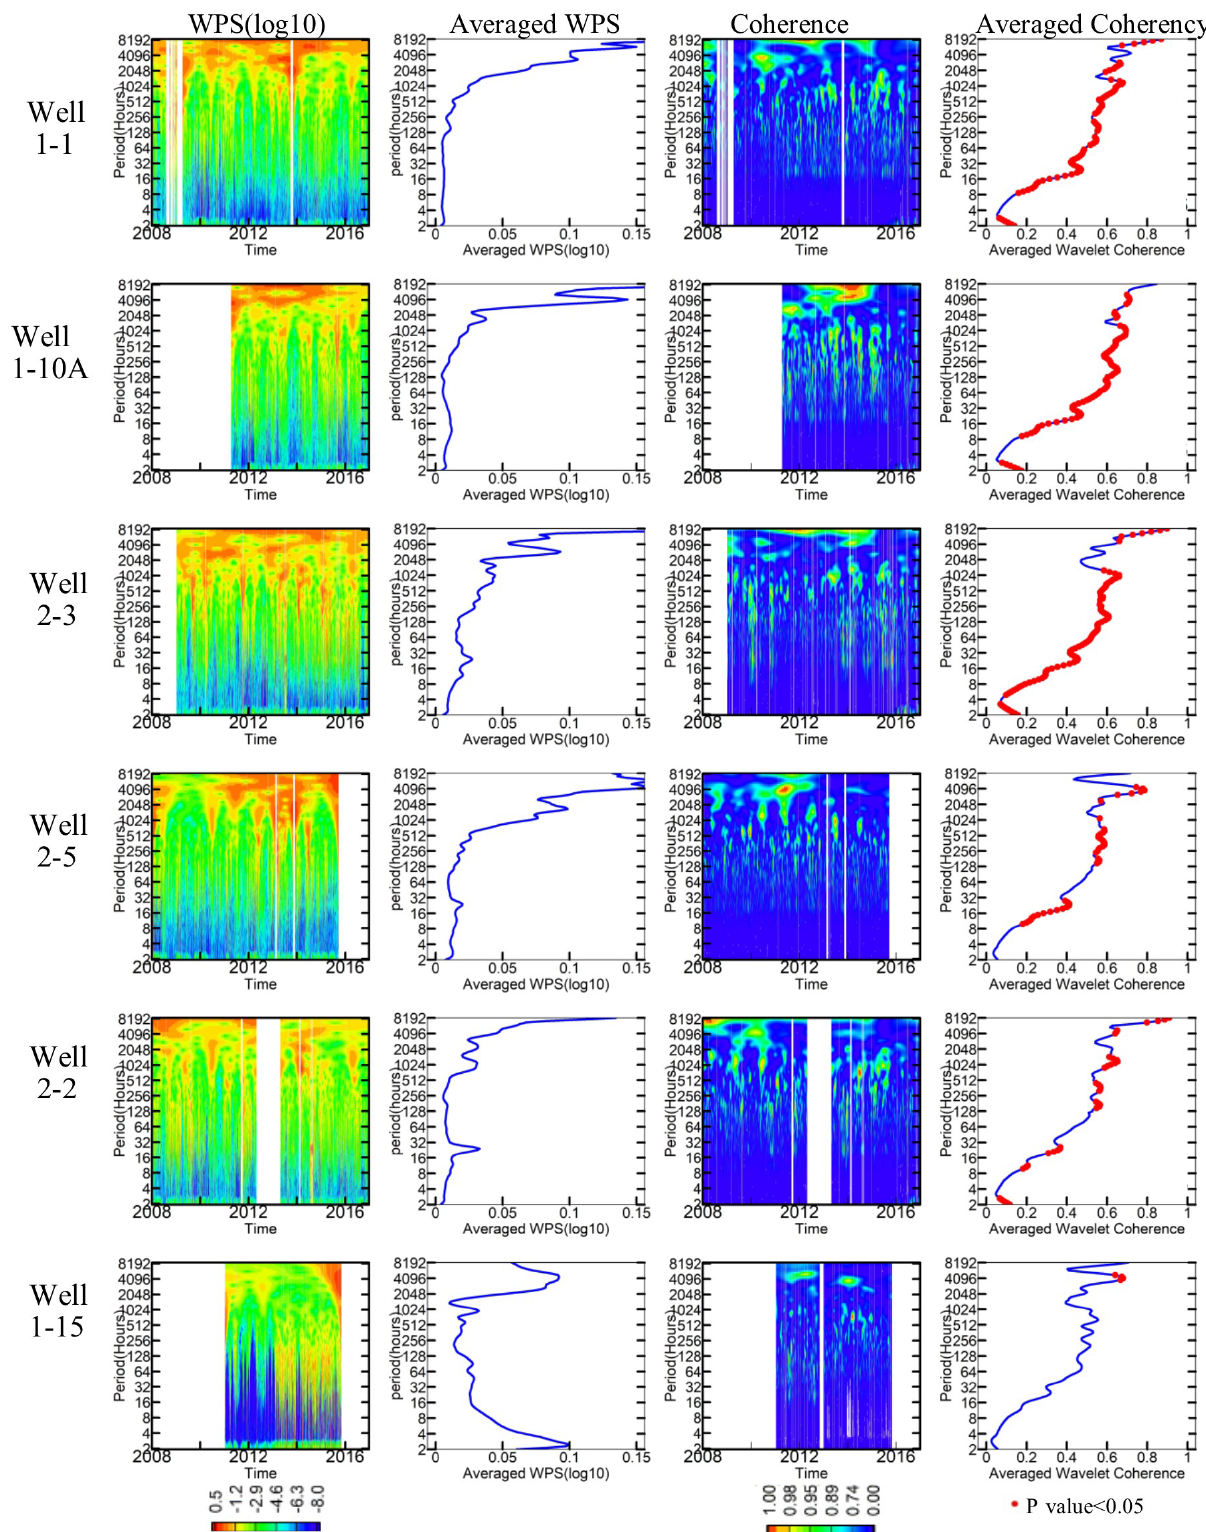
Figure 2. Wavelet power spectrum (WPS) analysis of SpC at each well from 2008 to 2018. The first column is the spectrogram (in log10 scale) of SpC in each well; the second column is the averaged WPS; the third column is the coherence between SpC in each well and the river stage; and the fourth column is the averaged coherence, with p < 0 . 05 values indicated in